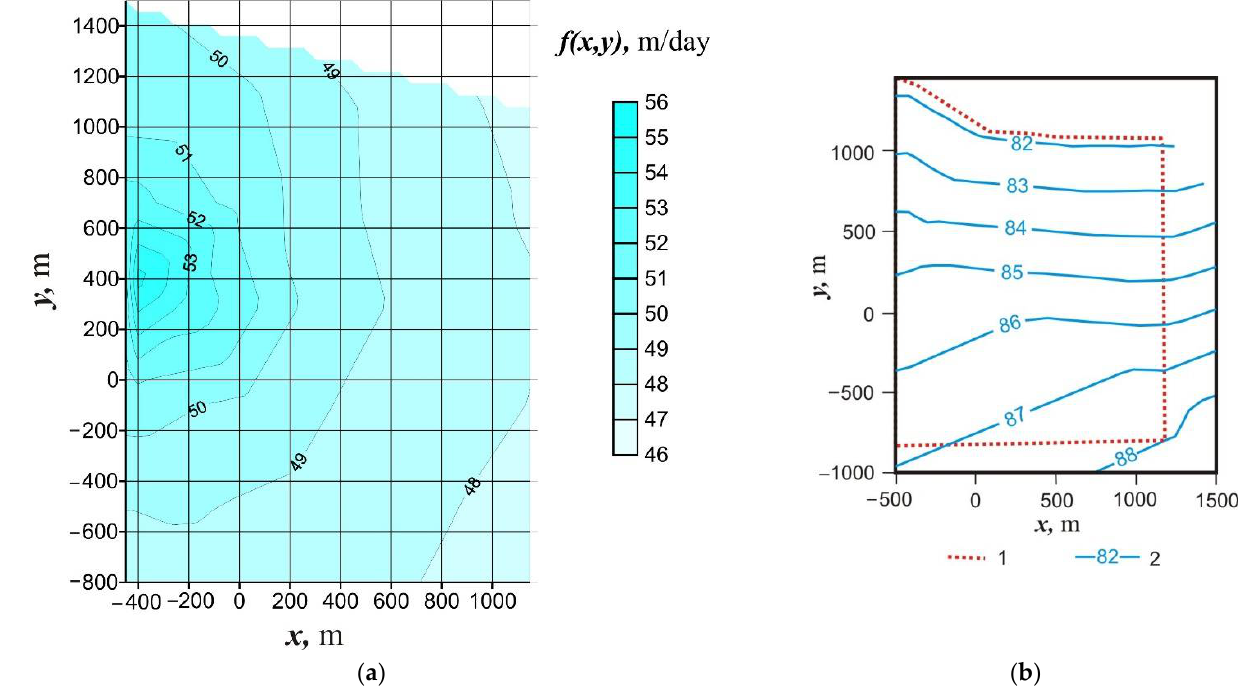
Figure 9. Calibration of the model of groundwater flow at APP Novovoronezhskaya. ( a ) Distribution of hydraulic conductivity of the free aquifer; ( b ) water table elevation levels.